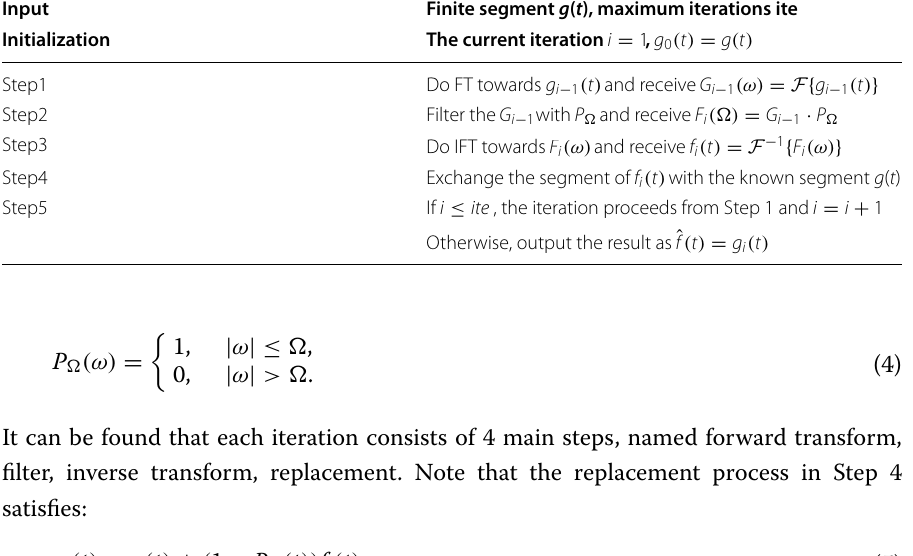
Table 1 GP extrapolation for a bandlimited function Input Finite segment g ( t ), maximum iterations